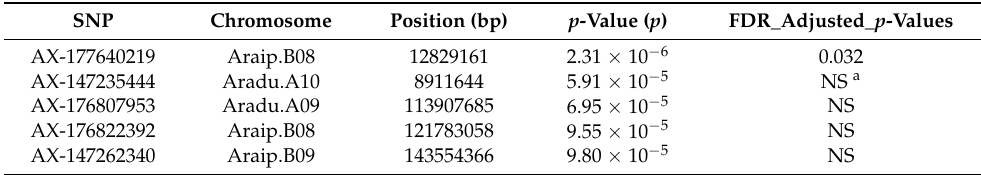
Table 1. Significant markers associated with seed aspect ratio of peanut identified using GAPIT